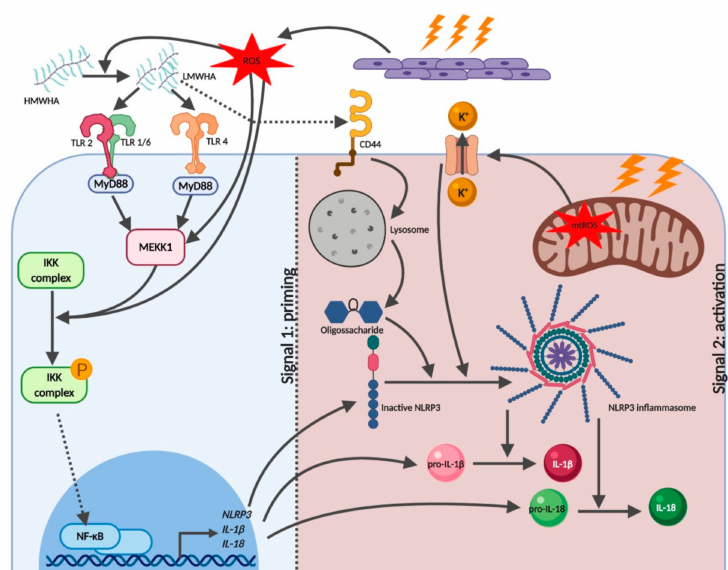
Figure 3. ROS and low-molecular-weight hyaluronic acid (LMWHA) involvement in both priming and activation of the NLRP3 inflammasome. ROS are rapidly produced in the skin following contact sensitizer treatment. ROS are responsible for triggering several intracellular cascades as well as promoting HA degradation. High-molecular-weight HA (HMWHA) is degraded into LMWHA, which is recognized by TLR2 and TLR4. Both TLR2- and TLR4- mediated signaling, as well as ROS, activate the NF- κ B pathway, leading to IL1 β , IL18 and NLRP3 transcription. Some allergens also induce mtROS production which leads to K + e ffl ux and NLRP3 inflammasome activation. LMWHA can activate NLRP3 inflammasome through CD44 (expressed on the surface of macrophages). CD44-LMWHA complex is further internalized and degraded by endosomes / lysosomes and the released oligosaccharides induce NLRP3 inflammasome activation. CD44, cluster of di ff erentiation 44. Created with